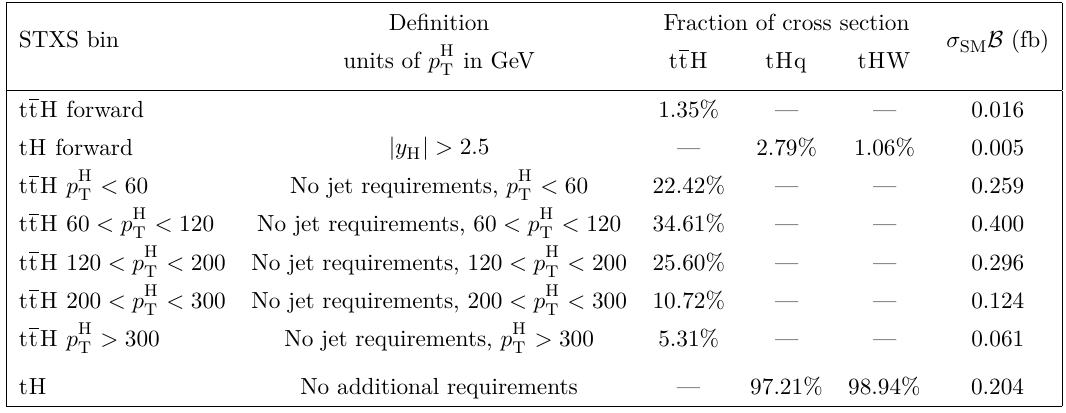
Table 8 . Definition of the ttH , tH , and bbH STXS bins. The product of the cross section and branching fraction ( B ), evaluated at last column. The fraction of the total production mode cross section from each STXS bin is also shown. Unless stated otherwise, the STXS bins are defined for | y